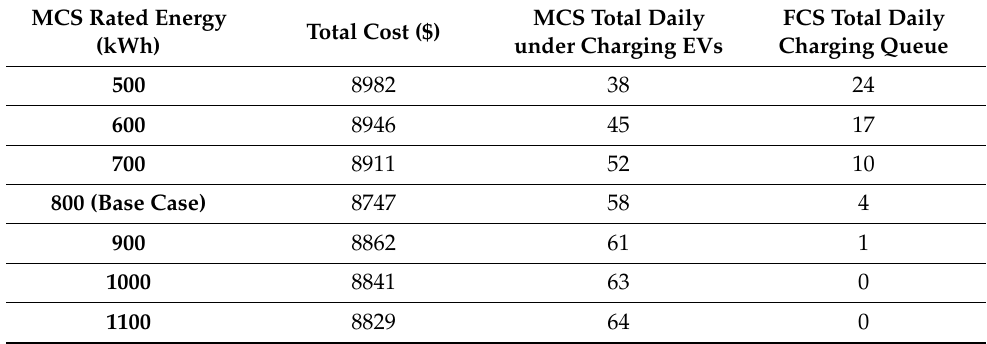
Table 3. Sensitivity of the results with respect to the MCS energy